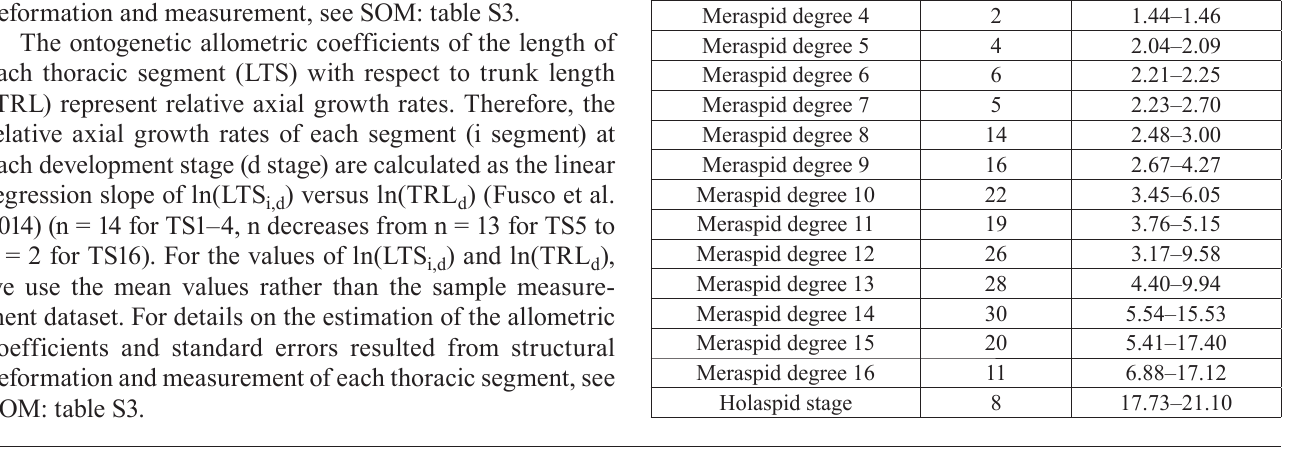
Fig. 3. Meraspid exoskeletons of oryctocephalid trilobite Changaspis elongata Lee in Chien, 1961 from the Balang Formation (Cambrian Stage 4), Jianhe County, Guizhou Province, South China. A . D4, JLZ-175-161; close-up of the 4 thoracic segments and pygidium (A 2 ). B . D5, JLZ-160-42; close-up of the last 3 thoracic segments and pygidium (B 2 ). C . D6, JLZ-160-555; close-up of the last 4 thoracic segments and pygi dium (C 2 ). D . D7, JLZ-160-1359; close-up of the last 4 thoracic segments and pygidium (D 2 ). The arrows represent the position of the thoracic- pygidial boundary. Scale bars 0.5 mm.